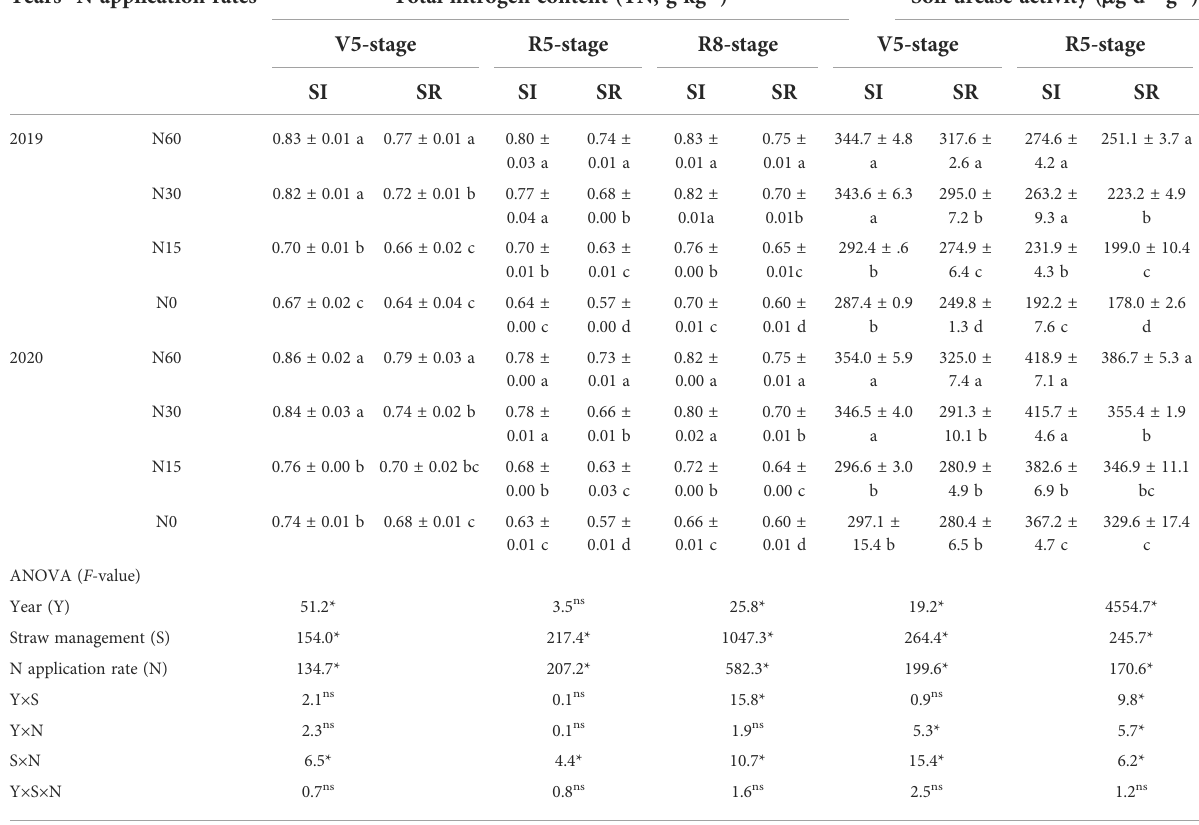
TABLE 1 Soil chemical properties of intercropped soybean at different growth stages. Years N application